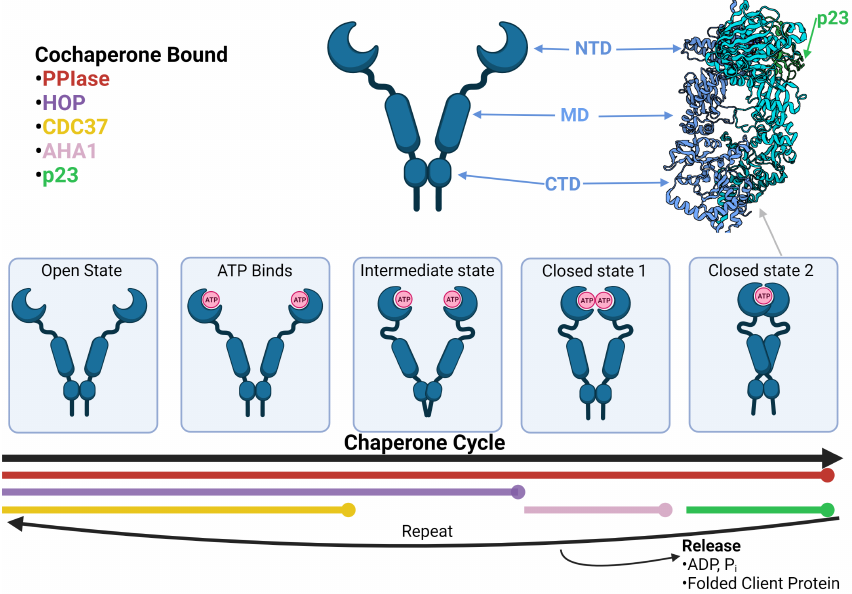
Figure 1. Hsp90 structure and chaperone cycle. The Hsp90 homodimer goes through multiple conformational changes while folding client proteins. The phases when certain cochaperones, PPIase, HOP, CDC47, AHA1, and p23, bind are labeled by color. In the top right is the Cryo-EM structure of Hsp90 complexed with p23 in closed state 2 (PDB ID: 7L7J from [32]). The domains of Hsp90 are labeled NTD, MD, and